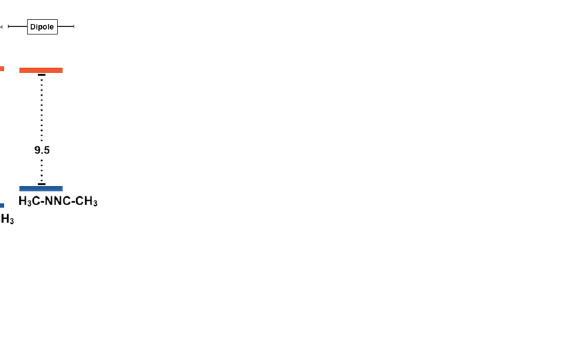
Figure 4. HOMO-LUMO gaps (eV) for the different neutral dipolarophiles (N 2 , FH···N 2 , HLi···N 2 , H 2 Be···N 2 ,